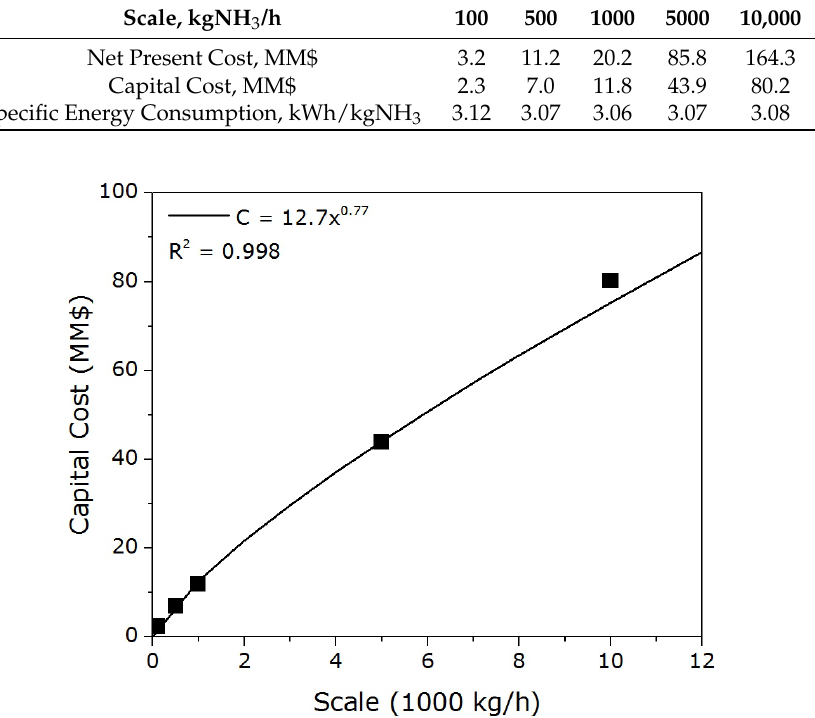
Figure 2. Absorbent-enhanced ammonia synthesis capital cost power